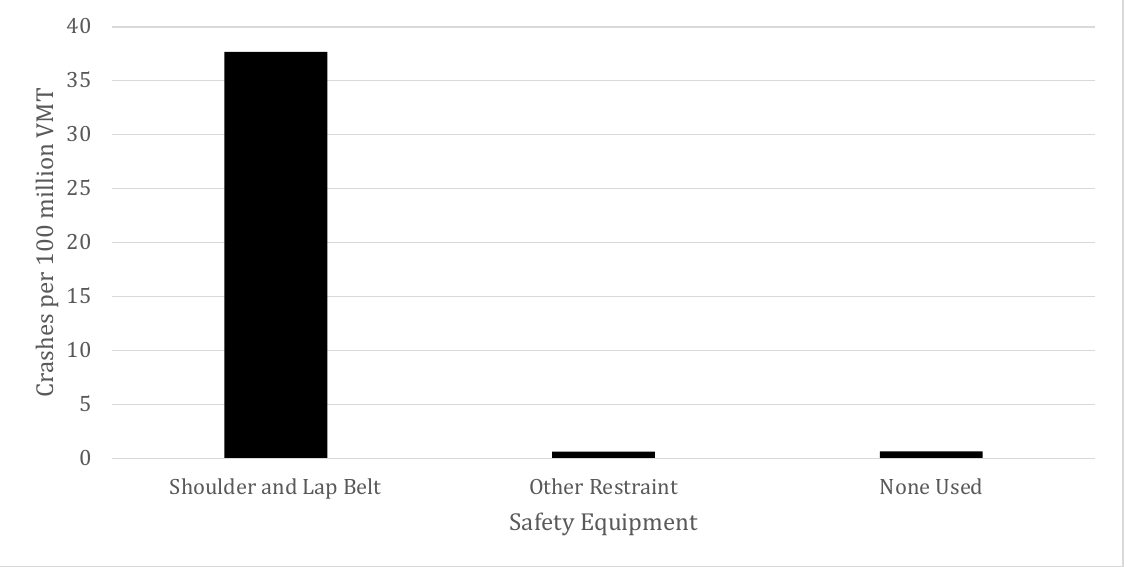
Figure 5 (c): Rate of animal-vehicle crashes based on safety